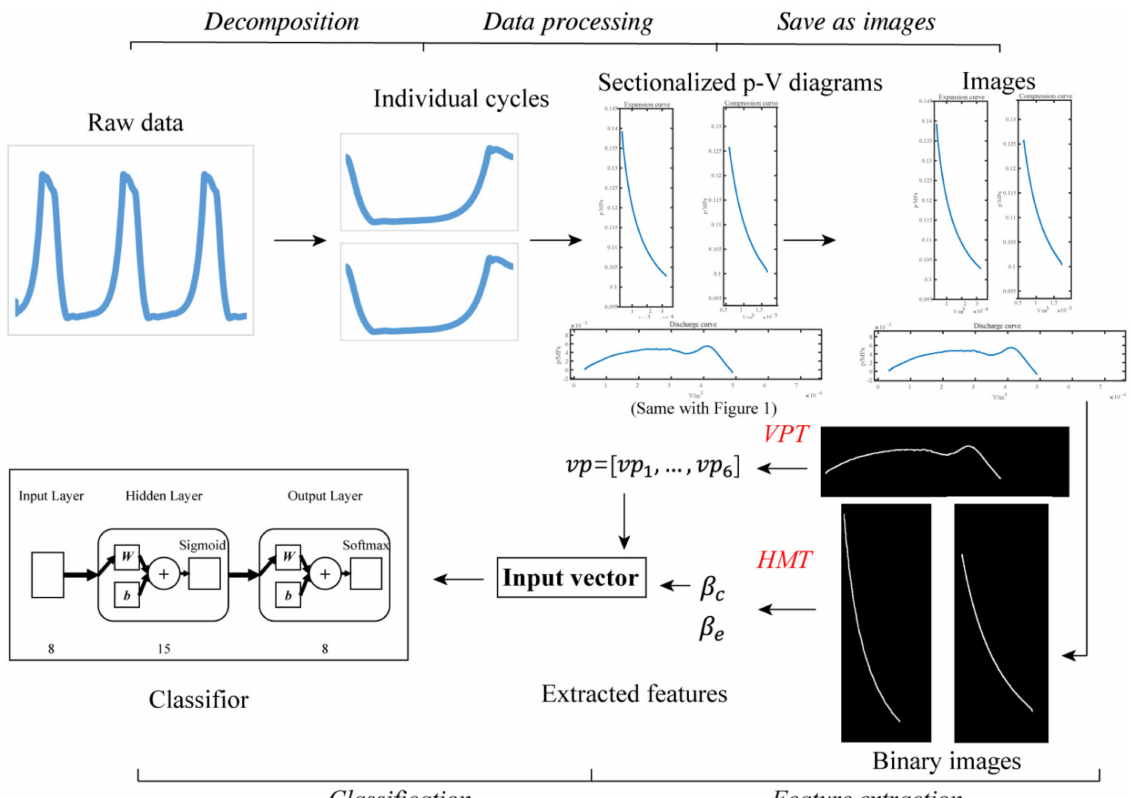
Figure 4. The flow block diagram of the proposed